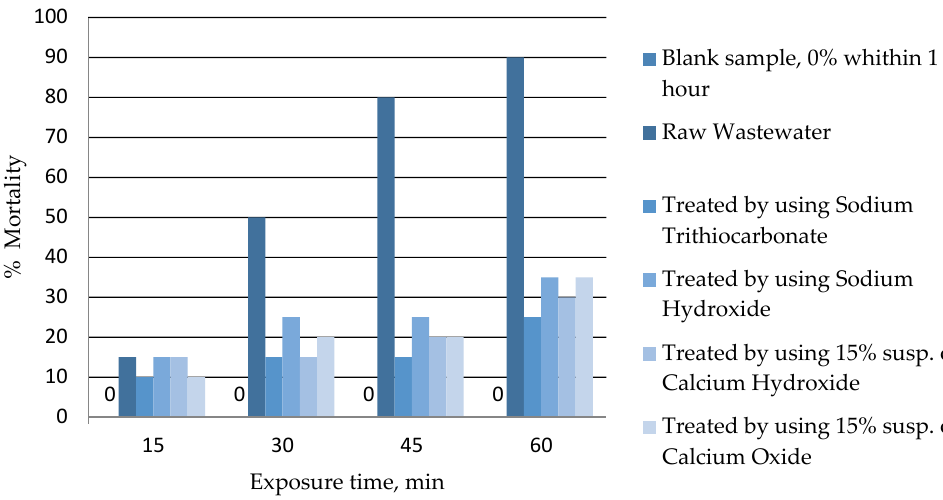
Figure 4. The results of the wastewater toxicity assessment against rotifer B. plicatilis .